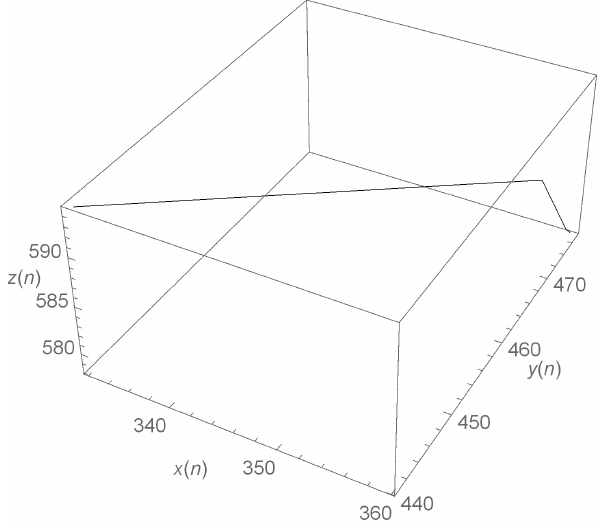
Figure 5. Attractor of x n , y n and z n for α = 167, β = 0.01, γ = 0.03, δ = 0.4, ζ = 155, η = 0.05, µ = 0.05, ε = 0.3, υ = 144, ρ = 0.03, σ = 0.08, ω = 0.2. with initial conditions x 0 = 10.0, y 0 = 20.0 and z 0 = 25.0.